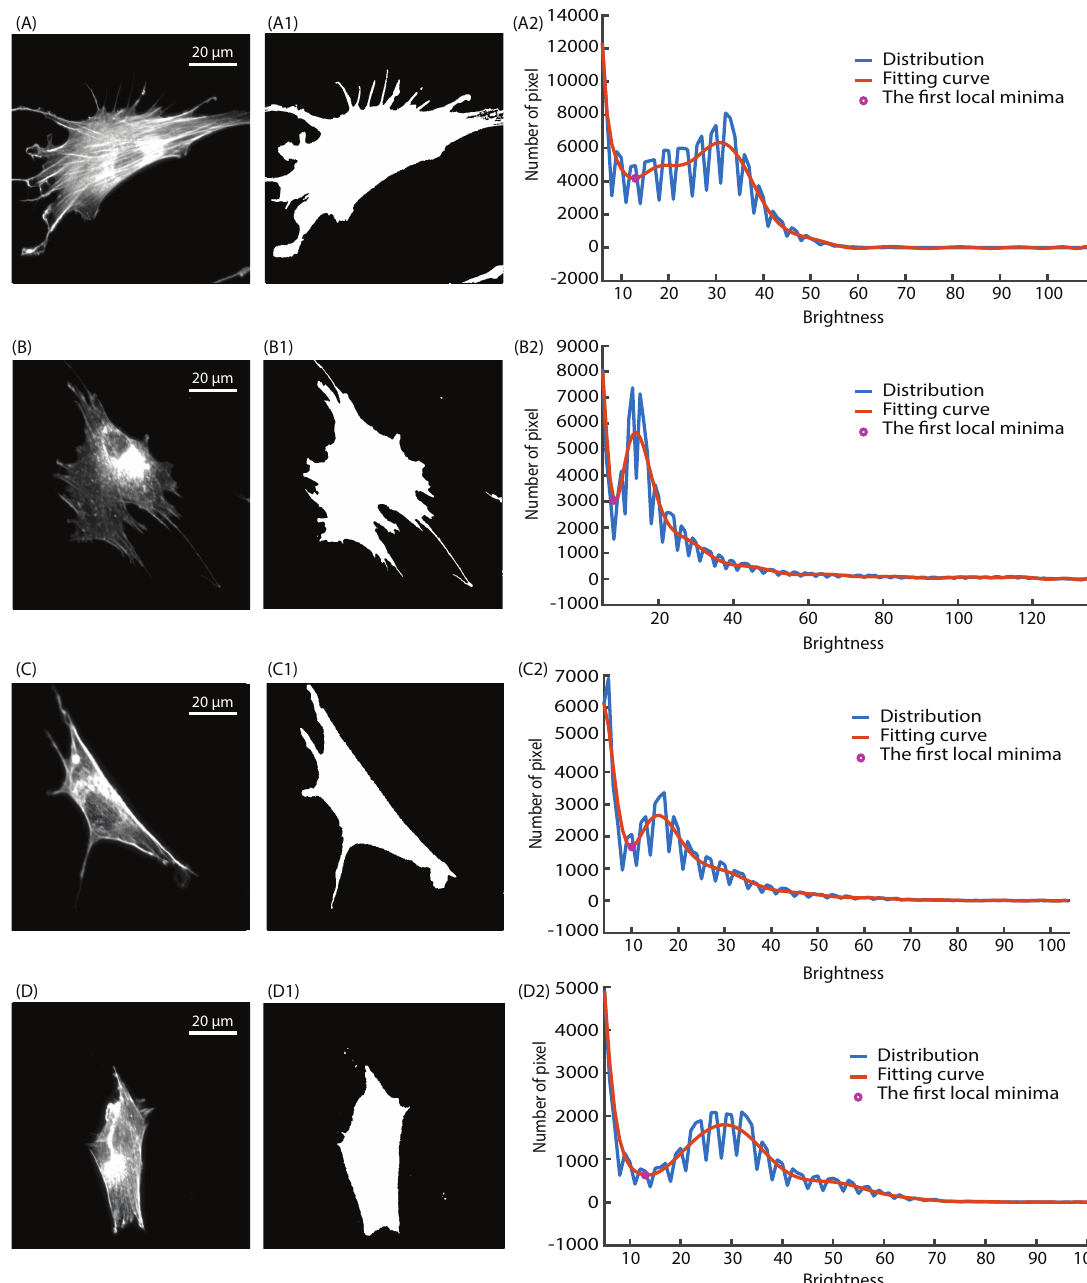
Figure 8. Example actin cytoskeleton images of cells with latrunculin B treatment concentrations of: ( A ) 0 nM; ( B ) 187.5 nM; ( C ) 375 nM; ( D ) 750 nM; ( A1 – D1 ) are the detected cell area of ( A – D ) using the Sobel edge detector and the hole-filling tool, respectively; ( A2 – D2 ) are the brightness distribution of ( A – D ), respectively. The blue curves denote the count of pixels at each specific brightness; the orange curves are the fitting result of its distribution; the circle denotes the first minimal intensity of the fitting